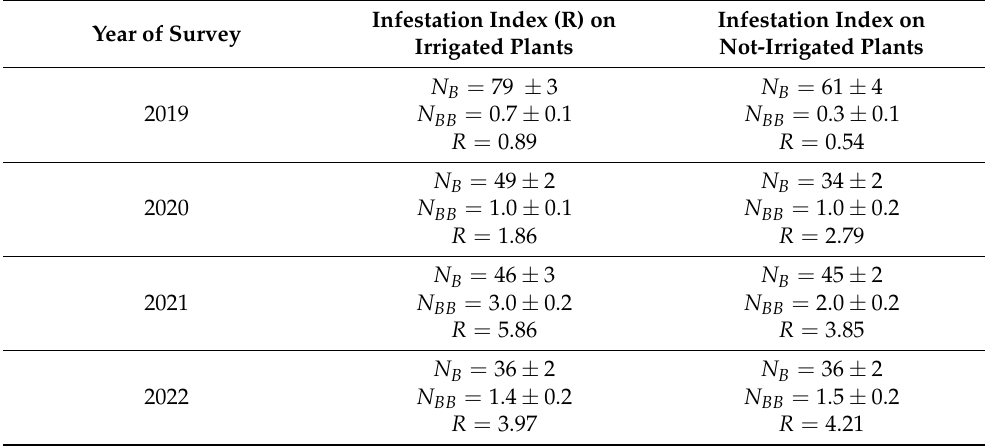
Table 1. Infestation index for the irrigated and not-irrigated plants over the years, calculated according to Equation (1). N B is the average number of not deformed buds per plant (mean ± SE), N BB is the average number of big buds per plant (mean ± SE), R is the infestation index (%). Infestation Index (R) Year of Survey